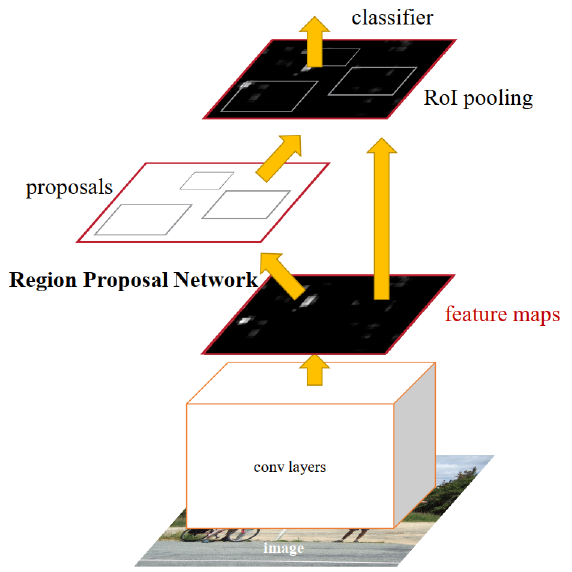
Figure 6. Explained architecture of Faster R-CNN. Image is obtained from